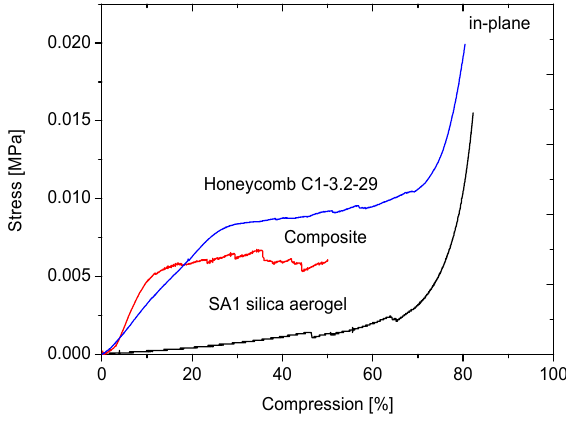
Figure 13. Compression curves of SA1 with C1-3.2-29 in-plane.